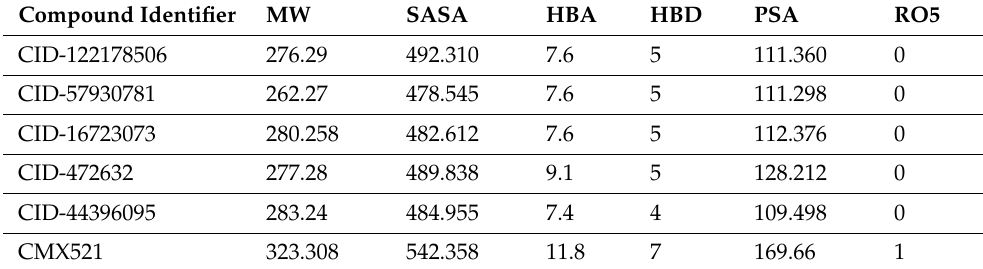
Table 2. Physicochemical profiles of the lead compounds and the reference compound using